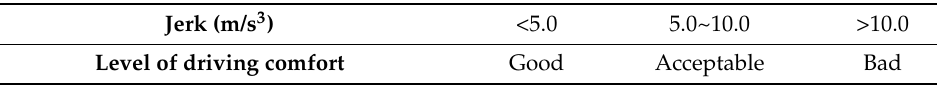
Table 1. Jerk criteria for driving comfort in automotive industry.